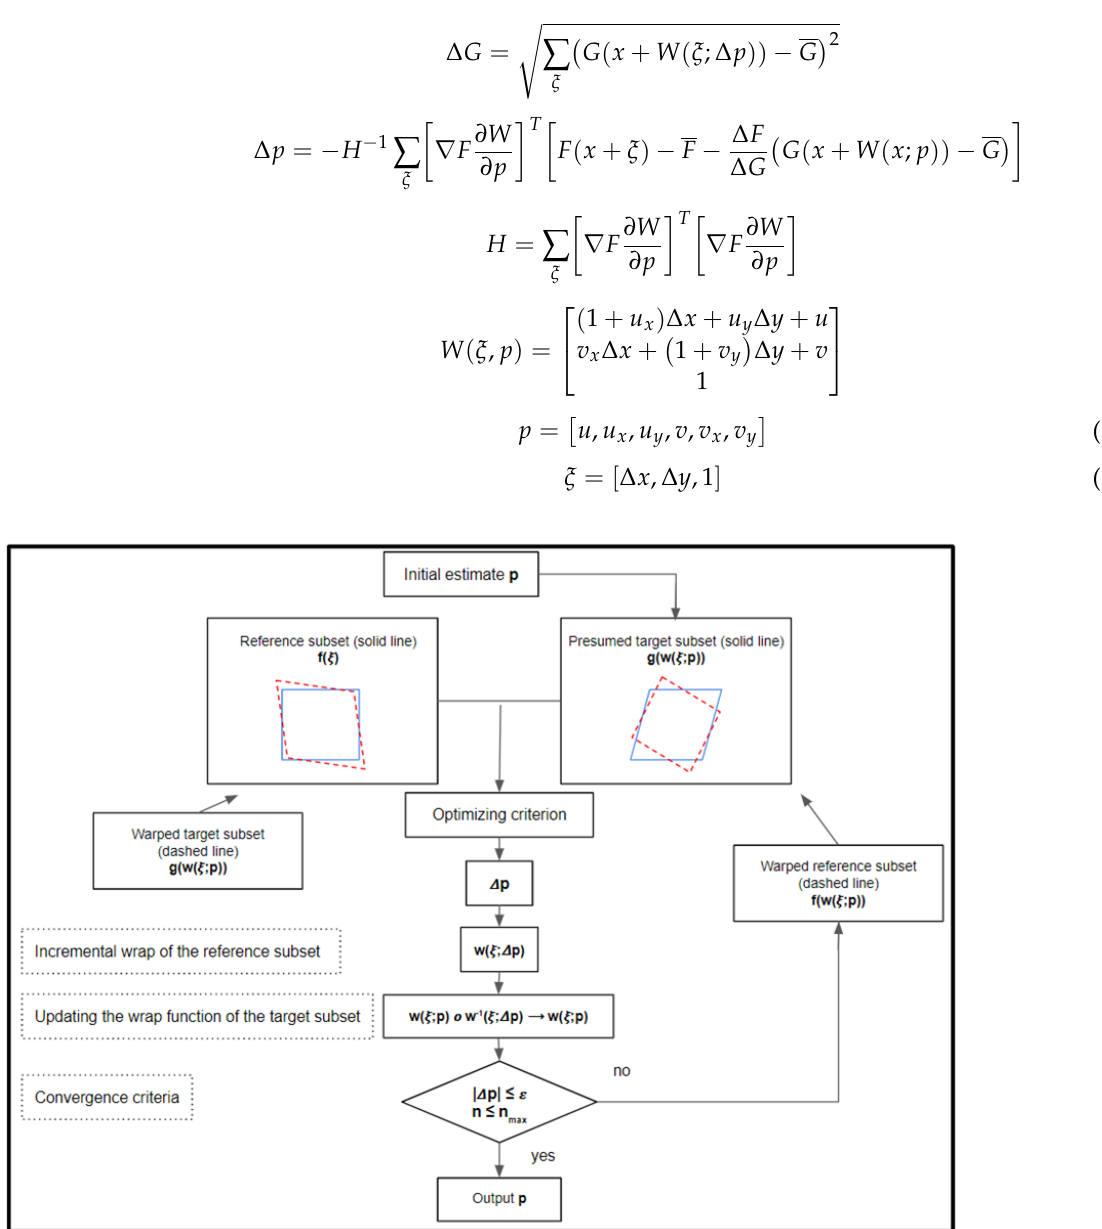
Figure 5. Scheme of the principle of the inverse compositional Gauss – Newton algorithm.